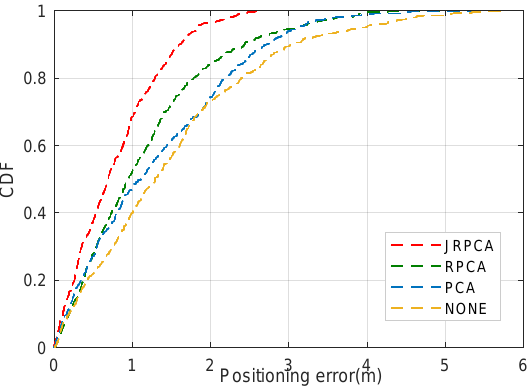
Figure 7. Mean error versus the number of AP used.